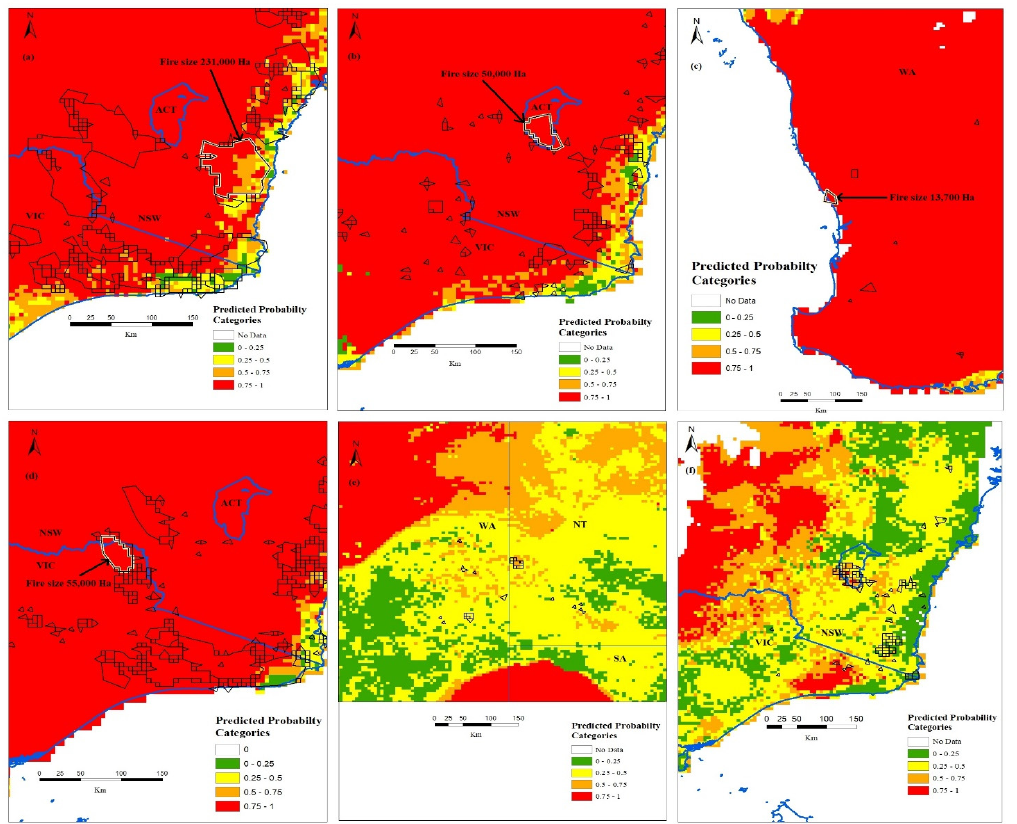
Figure 7. Predicted fire size probability categories vs the fire sizes (shown in black outline polygons) for the Black Summer fires (2019–2020, Australia). The first four images also include fire sizes reported by Fox, et al . [70] (shown in white outline and indicated by the arrow) : ( a ) Badja Forest Road, (NSW) fire burnt an area of approximately 231,000 Ha in the first week of January (1–8) 2019; ( b ) Orroral Valley fire, (ACT) burnt an area of around 50,000 Ha from 25 January–01 February 2020; ( c ) Yancep fire (WA) burnt an area of approximately 13,700 Ha from 11–18 December 2019; ( d ) Corryong fire (VIC) burnt an area of around 55,000 (Ha) in the last week of December (27–31) 2019. The predicted probability categories vs the fire sizes shown here are on weekly scale. Thus the total fire area in these fire events may vary in total quantity and duration as compared to those mentioned in [70], because of the difference in duration of the time the fires kept burning. Note that the majority of the model predictions in the first four images fall in the highest probability category (0.75–1) because of the extreme fire danger conditions in the 2019–2020 fire season. The last two images show randomly selected images with lower predicted fire size probabilities and corresponding fire sizes: ( e ) 1–8 January 2020; ( f ) 10–17 February 2020.